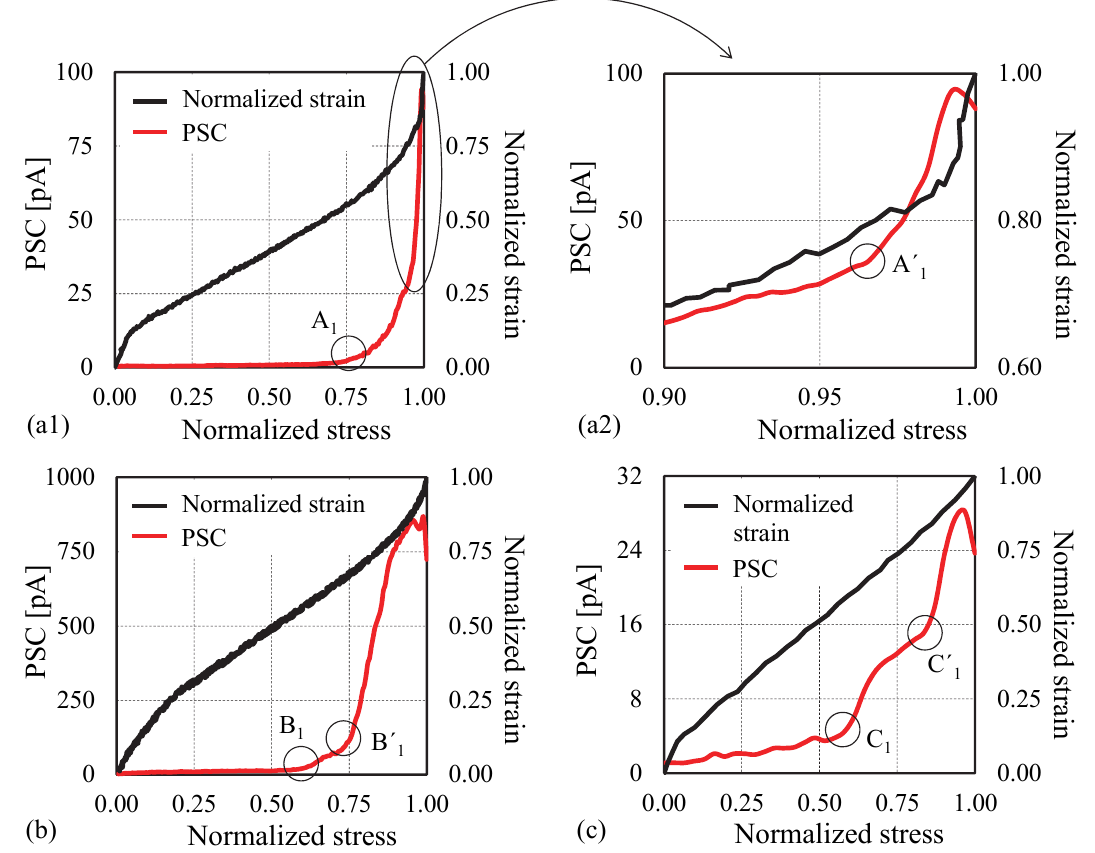
Figure 3: The electric current and the normalized axial strain versus the normalized stress for a typical specimen of (a) marble, (b) mortar and (c)